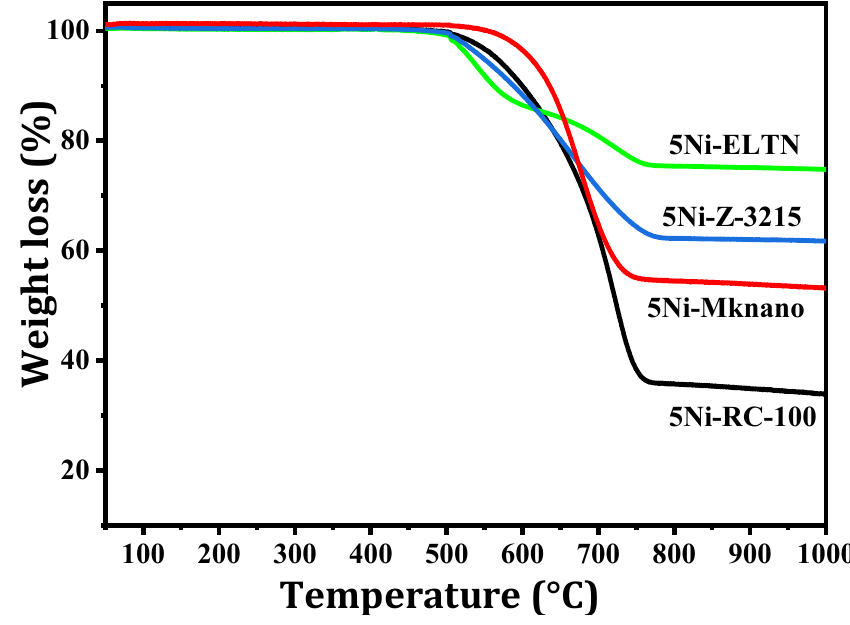
Figure 9. TGA profile of different ZrO 2 sources supported Ni catalysts .